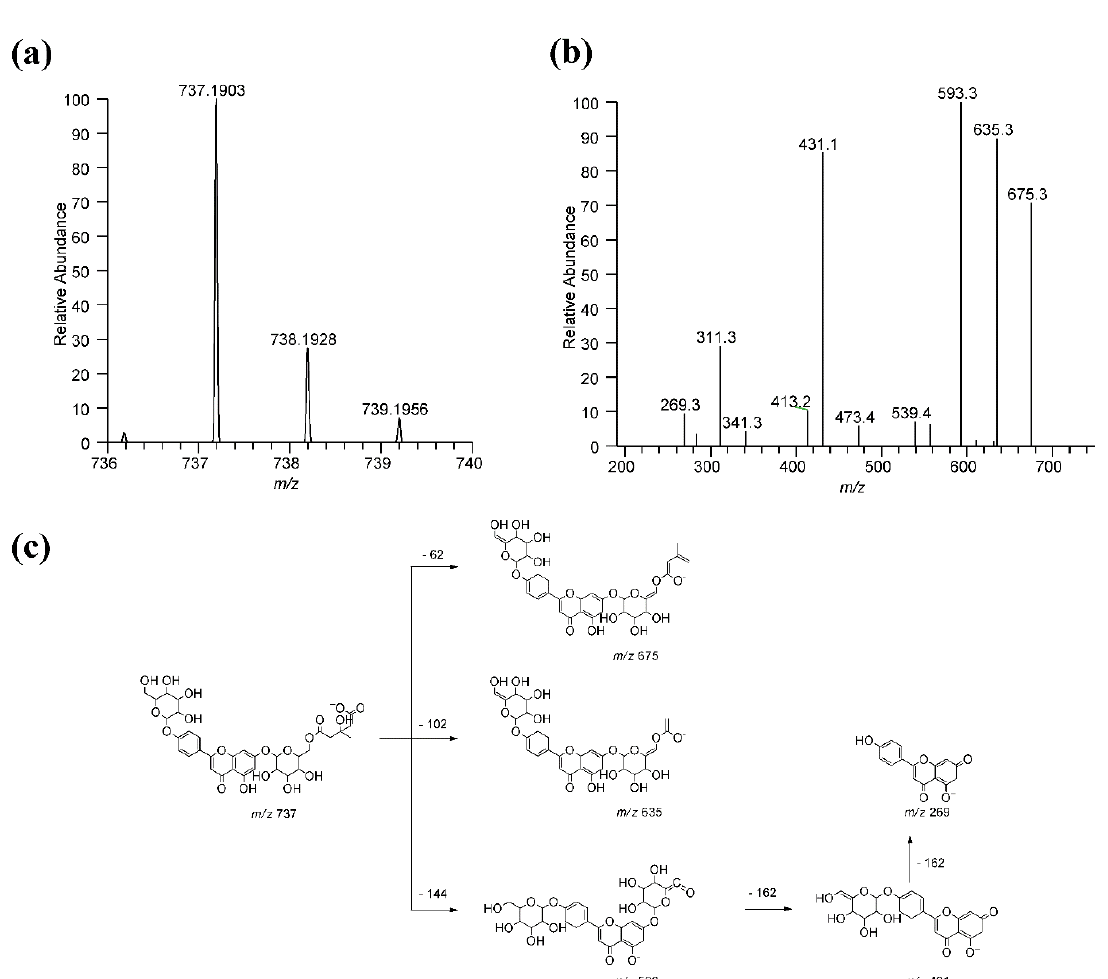
Figure 2. Identification of apigenin-di -O- glucoside -O- HMG by MS and MS/MS studies. Panel ( a ): full mass spectrum with accurate mass and isotopic pattern; panel ( b ): MS/MS spectrum; panel ( c ): proposed fragment tree MS/MS